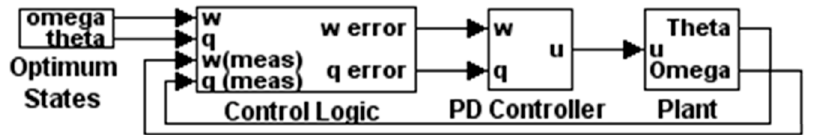
Figure 8. Feedforward/feedback implementation in SIMULINK.